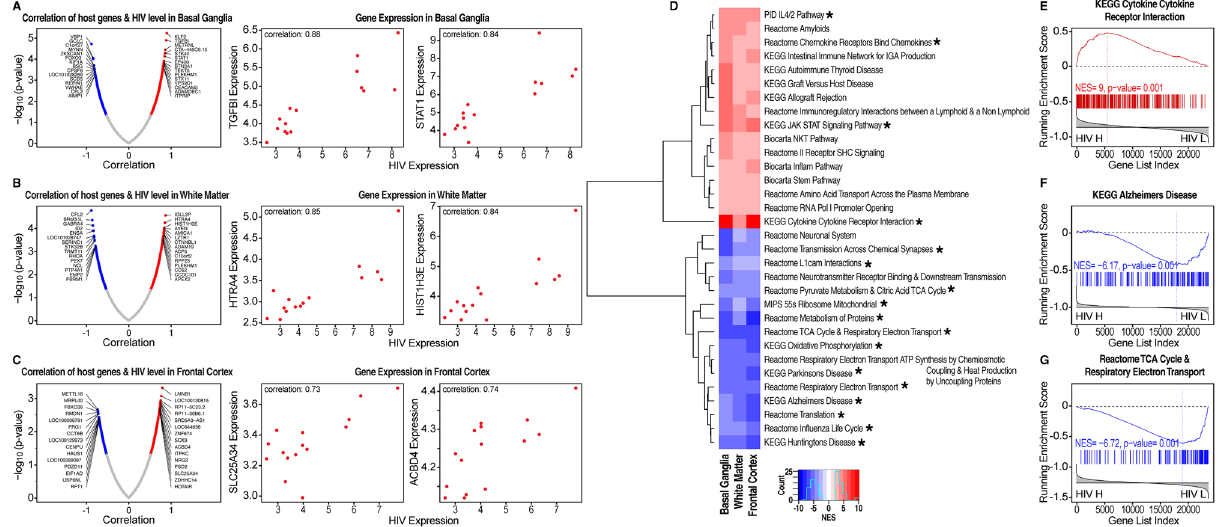
Figure 1. Correlation of gene expression and pathway dysregulation with brain HIV RNA load in brain regions of patients with HIV. ( A – C ) Host genes that correlated with brain HIV RNA load in three brain regions of patients with HIV. Volcano plots depict significant correlation with brain HIV RNA loads in the three brain regions under study (left side; also see Supplemental Table S2) and representative examples of genes (plots on the right side). ( A ) Among the top genes that correlated with HIV expression in the basal ganglia were transforming growth factor-β-induced protein (TGFBI) and signal transducer and activator of transcription 1 (STAT1). ( B ) Among the top genes that correlated with HIV expression in white matter were HtrA serine peptidase 4 (HTRA4) and histone H3.1 (HIST1H3E). ( C ) Among the top genes that correlated with HIV expression in the frontal cortex were the mitochondrial carrier protein SLC25A34 and acyl-coenzyme A binding domain containing 4 protein (ACBD4). ( D ) Gene Set Enrichment Analysis of host genes that were concordantly correlated with HIV expression in all three regions (basal ganglia [BG], white matter [WM], and frontal cortex [FC]). Asterisk indicates pathways significantly concordantly dysregulated in all three brain regions (FDR < 0.05). ( E – G ) Representative host pathways that were concordantly correlated with HIV expression in all three brain regions that were indicative of ( E ) increase in cytokine signaling, ( F ) neurodegeneration, and ( G ) dysregulation of bioenergetics, between samples from patients with high brain HIV RNA load (HIV-H) and samples from patients with low brain HIV RNA load (HIV-L). The example in panel ( E ) is from the basal ganglia, the one in panel F is from the frontal cortex, and the one in panel ( G ) is from white matter. Similar results were obtained for these pathways in the three brain regions as shown in ( D ). Changes in the expression of the pathway in the GSEA plots, such as the ones in ( E – G ), are indicated by the asymmetric distribution of genes in the geneset (vertical bars) and of the line plot of the running normalized enrichment score 31